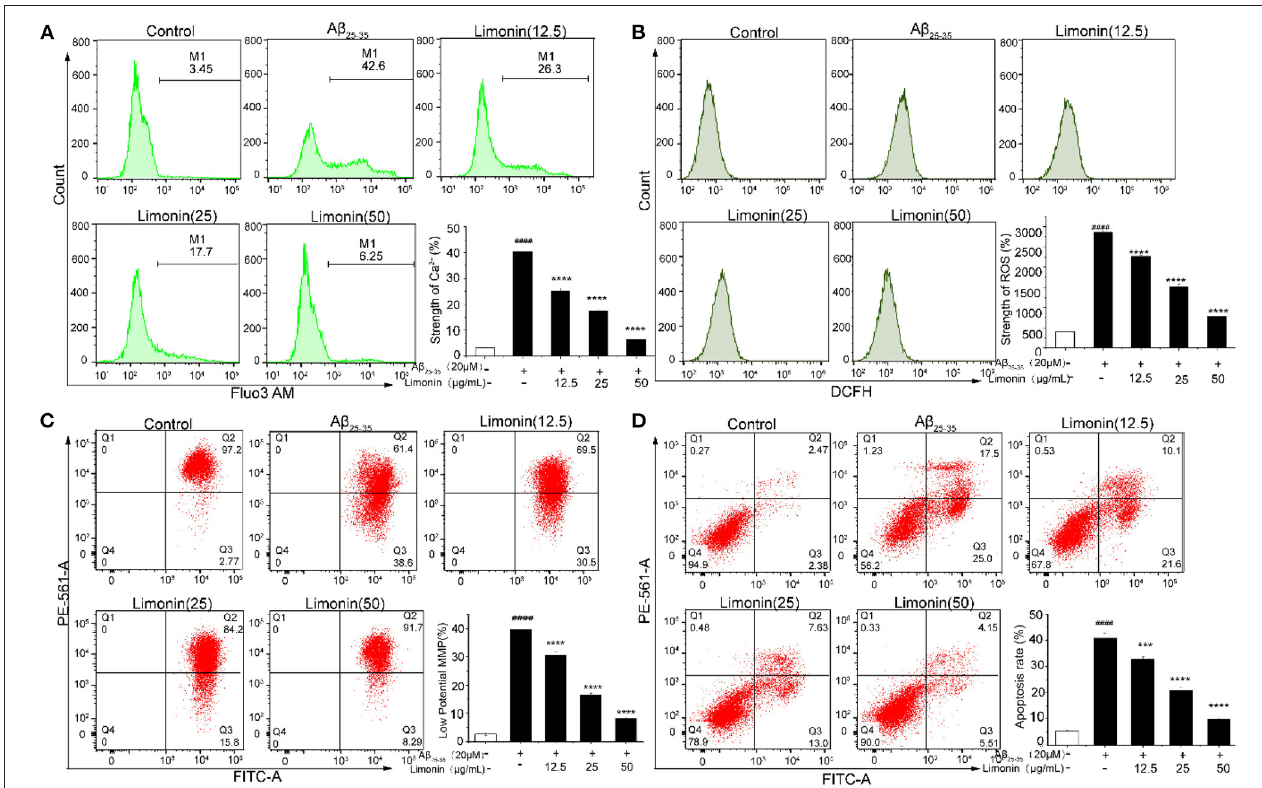
FIGURE 4 | The effect of limonin on [Ca 2 + ]i, ROS, MMP and apoptosis of PC12 cells induced by A β 25 − 35 treatment, analyzed with flow cytometer. (A) [Ca 2 + ]i release; (B) reactive oxygen species (ROS) levels; (C) mitochondrial membrane potential (MMP); (D) apoptosis. #### p < 0.0001 compared with the control group; *** p < 0.001 and **** p < 0.0001 compared with the A β 25 − 35